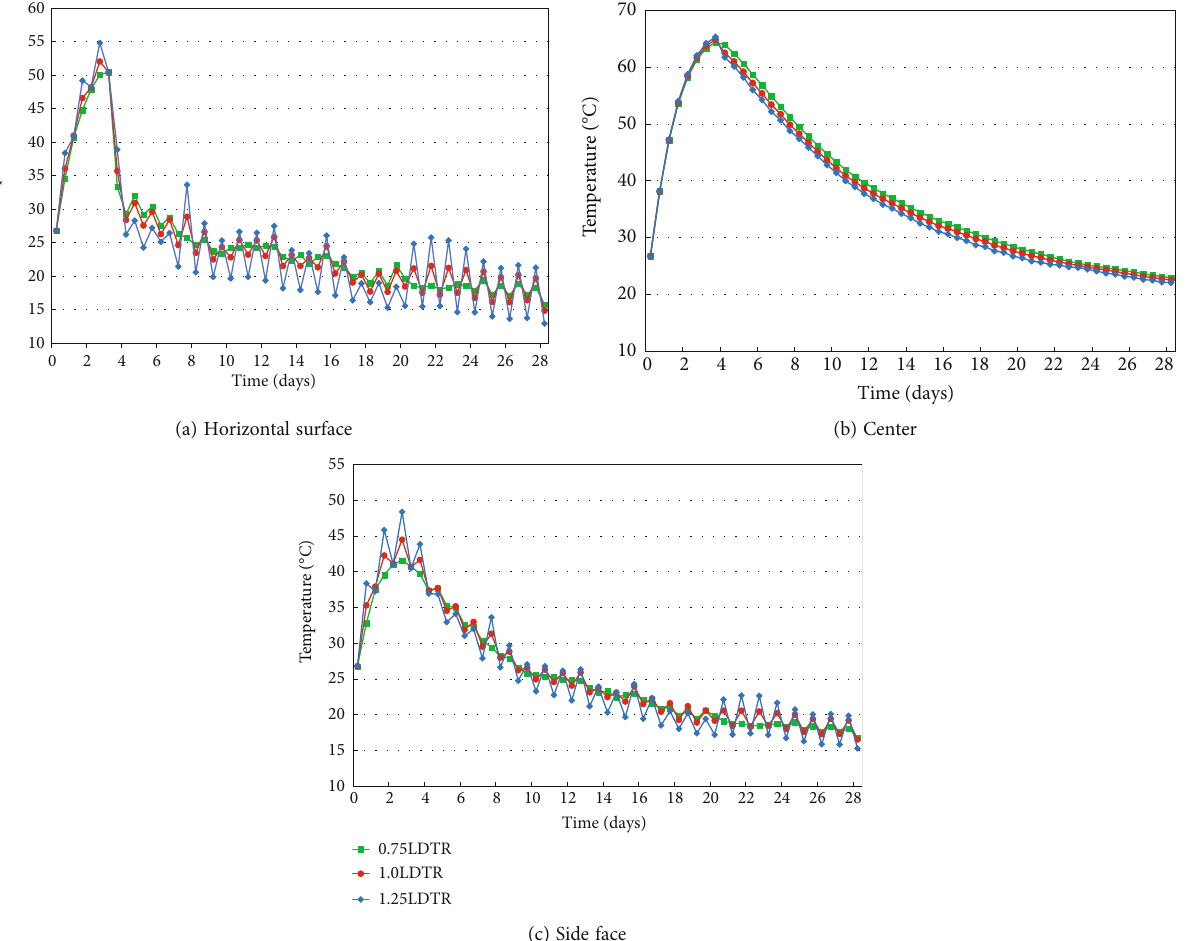
Figure 9: Maximum temperatures of concrete under di ff erent